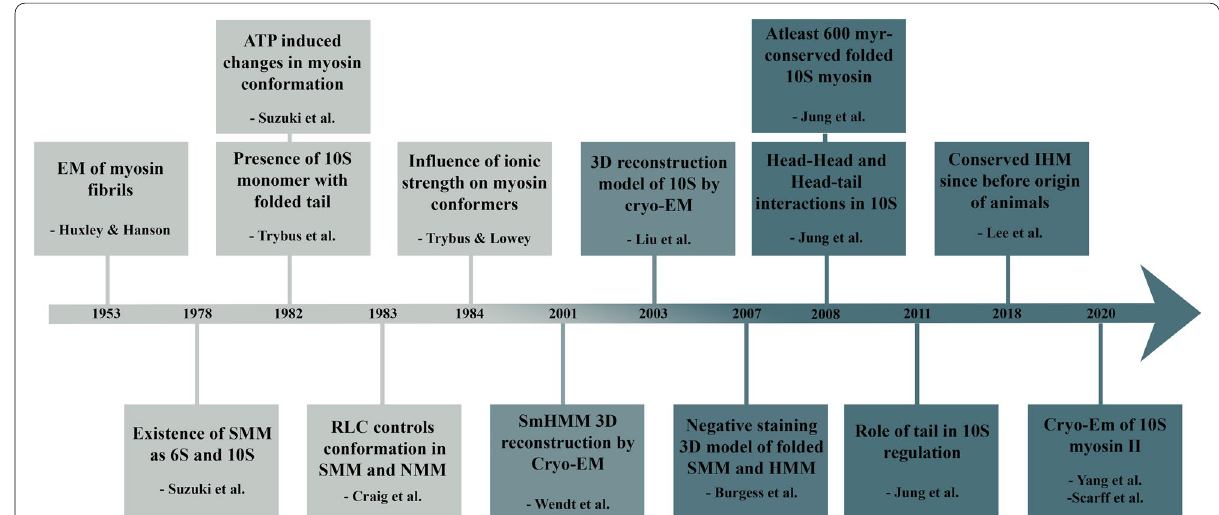
Fig. 2 Conclusive illustration of the timeline for major events in the development of smooth muscle myosin 10S structural